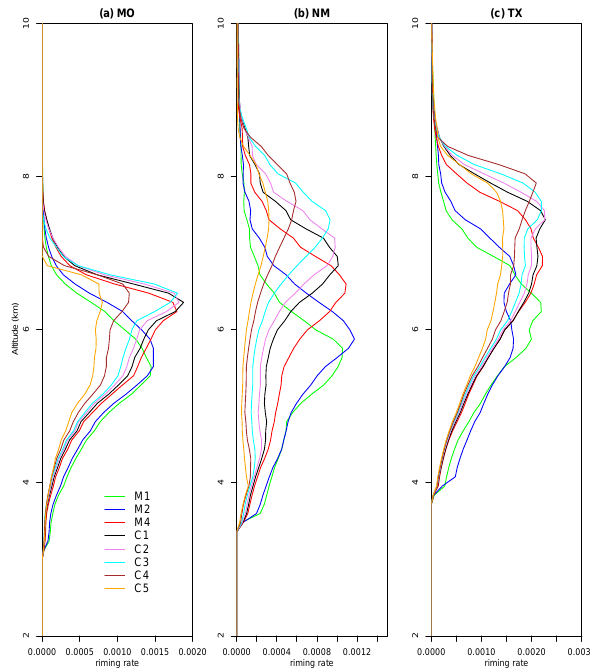
Fig. 9. Vertical variation of the mean riming rate for (a) MO, (b) NM and (c) TX clouds. The averages were taken horizontally and temporally.